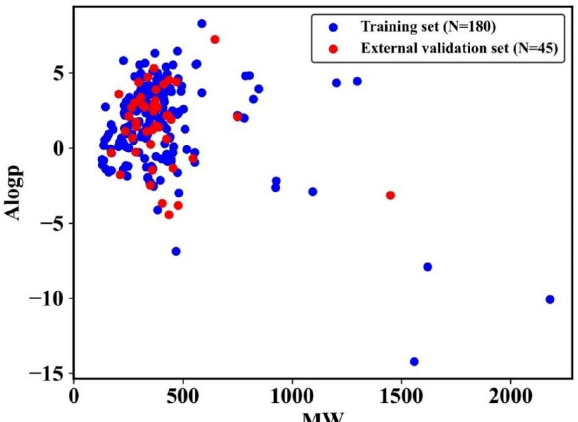
Figure 1. Chemical space distribution of compounds in the training and external validation sets.